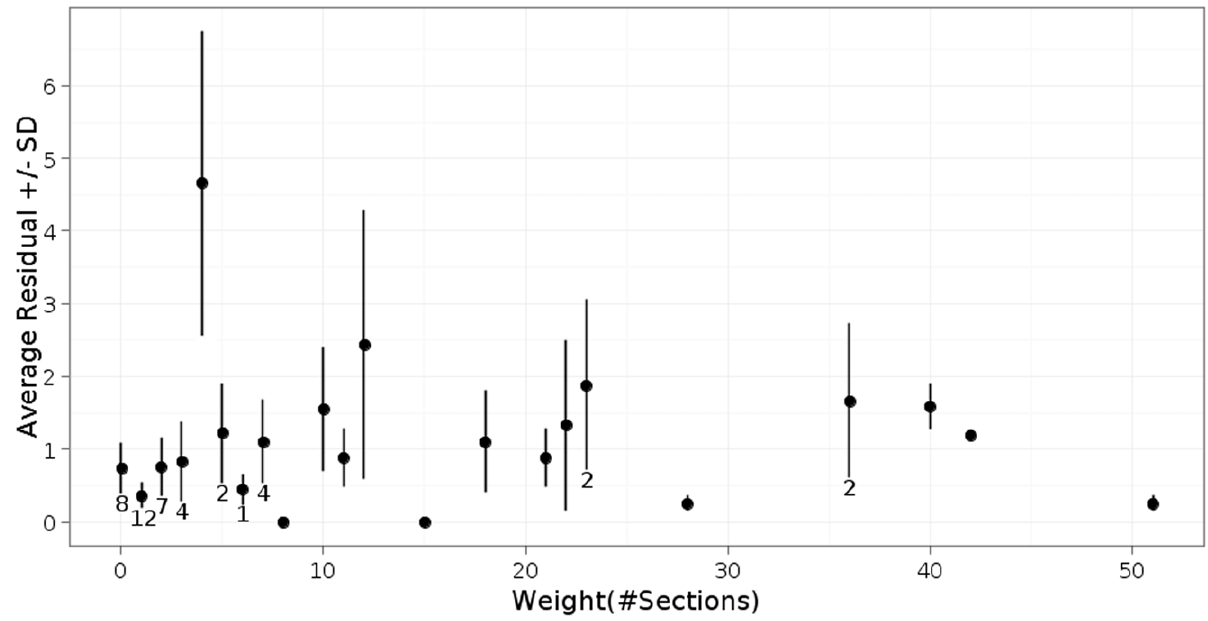
Figure 3. Error in determining connection strength. Average and distribution of edge weights (total amount of synaptic interaction) determined by three separate individuals for the 55 edges connecting the male-specific interneuron PVX to its 55 synaptic partners in the C. elegans male posterior connectome [9]. Edge weights are represented by the number of 70–90 nm serial sections of pre-synaptic densities. The weights are for a single edge except where indicated. Values of edge weights (abscissa) are the weights assigned by one of the three scorers, arbitrarily chosen. Weight values typically differed by 1 to 2 sections.